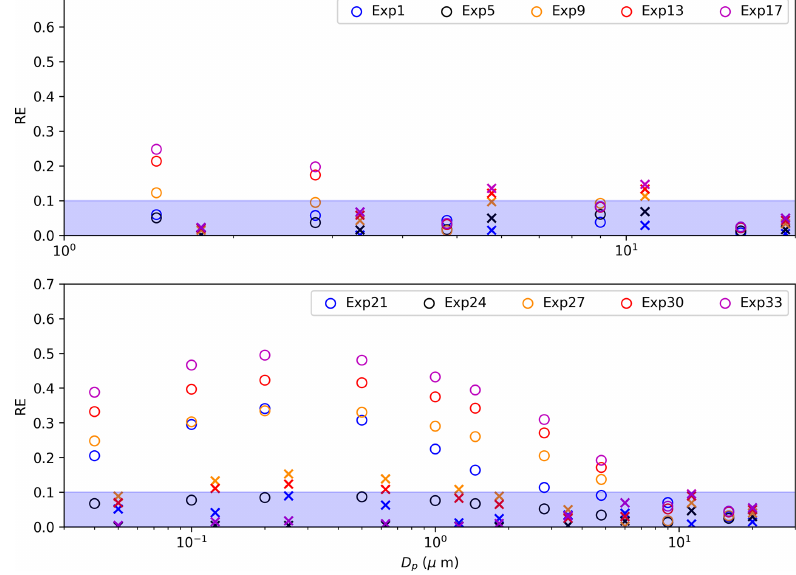
Figure A2. RE changes with particle size under weak wind